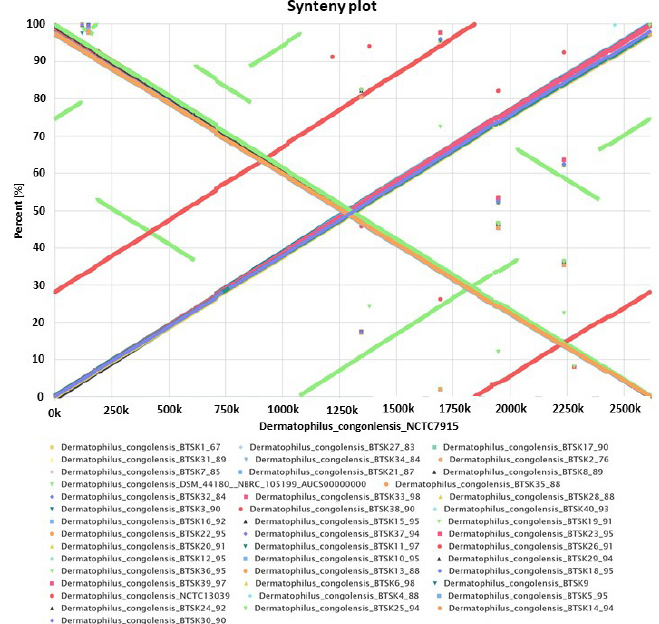
Figure 3. Synteny plot of 40 D. congolensis genomes depicting the conserved order of genes. We plotted all 40 because all 40 genomes in comparison to the reference showed the same gene order.